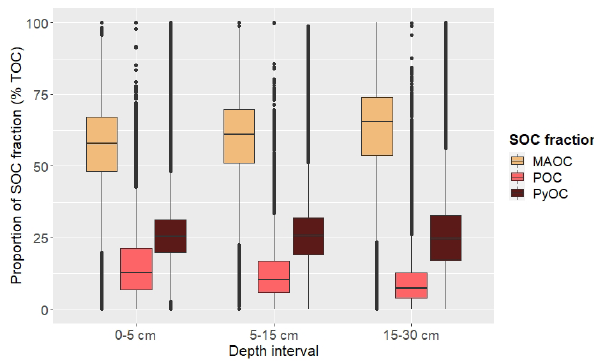
Figure 4. Distribution of TOC among three SOC fractions in the spectral dataset: MAOC, POC, and PyOC.